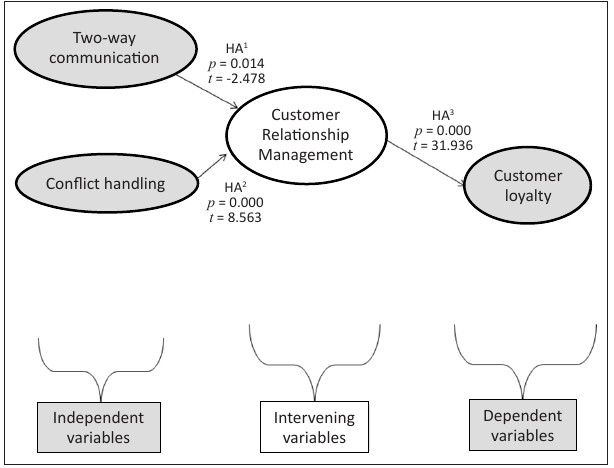
Conflict handling